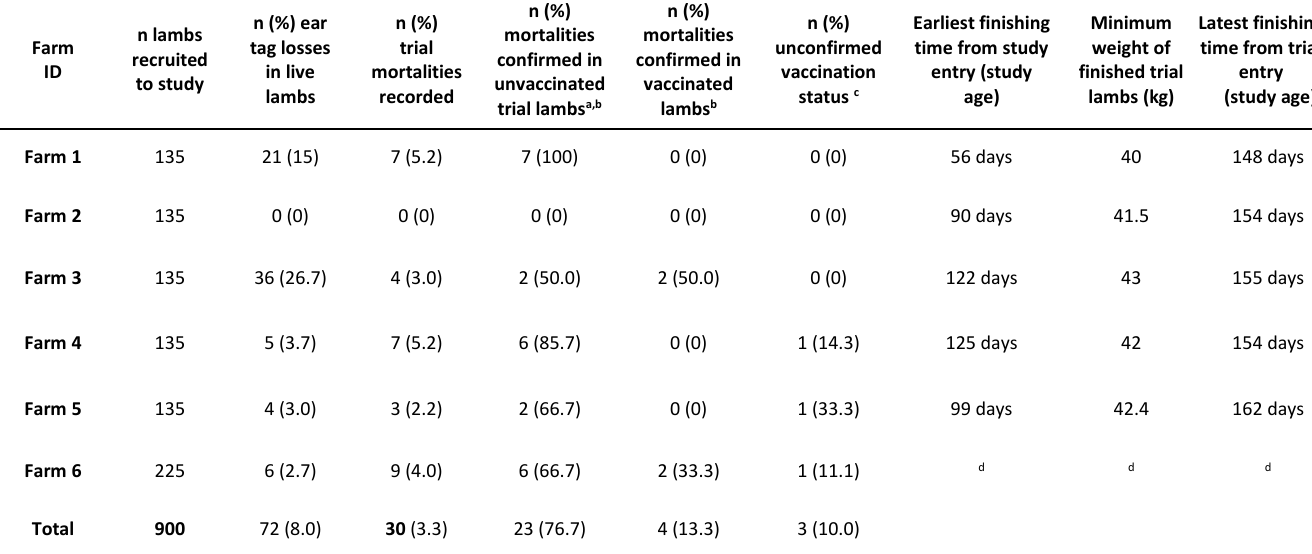
times and minimum weight of finished trial lambs on six sheep